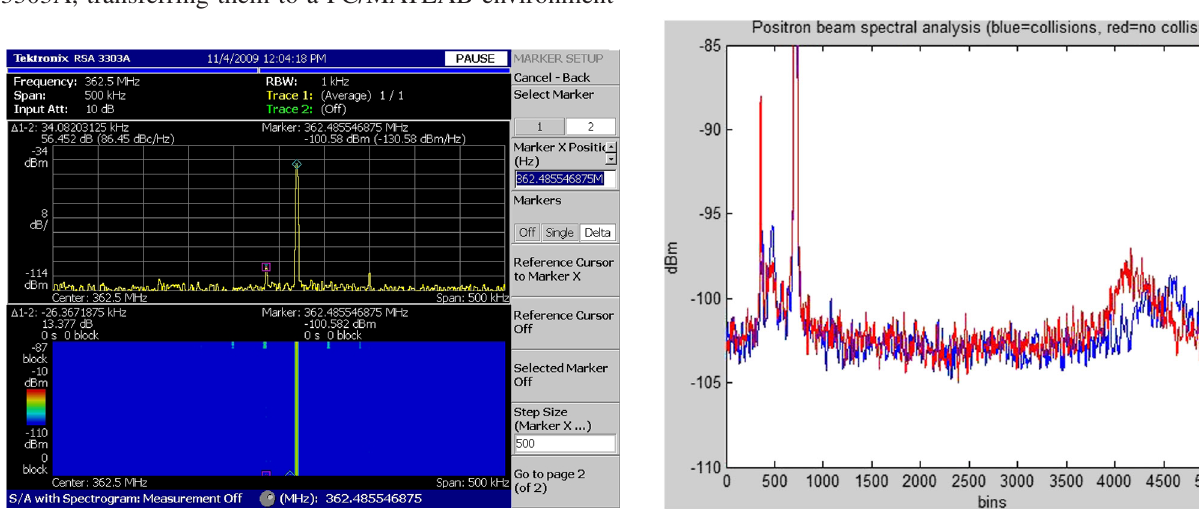
FIG. 4. Positron spectrum in collision (blue) and off collision (red), showing the longitudinal and horizontal tunes.